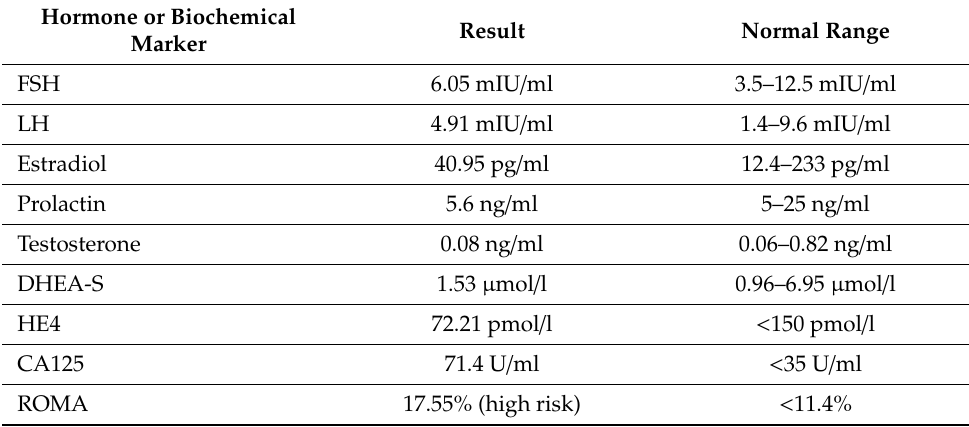
Table 6. Hormonal